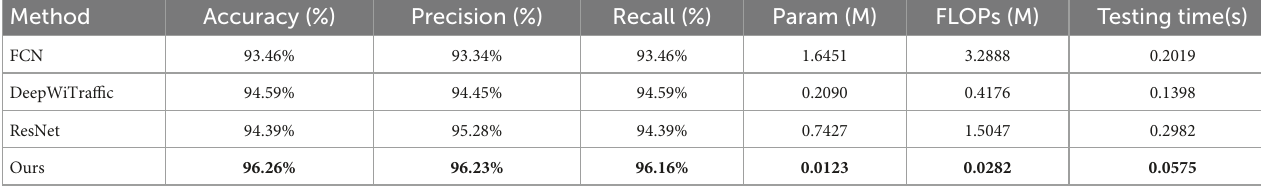
TABLE 1 Performance comparison of different methods on four-category dataset.